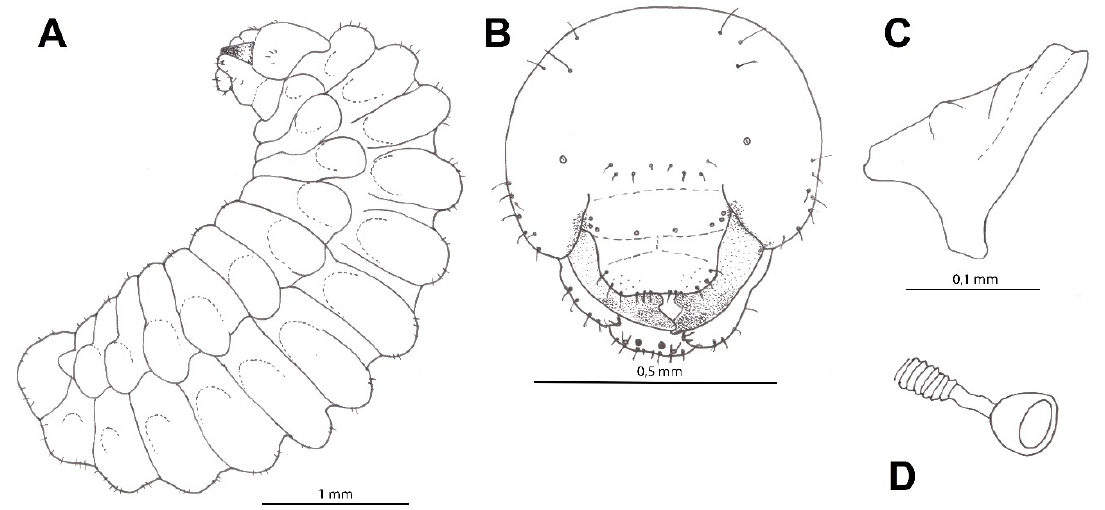
Figure 5. Larva of Oxybelus variegatus : ( A ) body, lateral view; ( B ) head, frontal view; ( C ) mandible, frontal view; ( D ) spiracle .